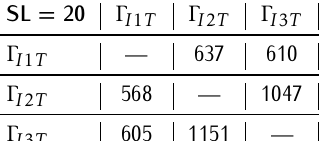
— Table 10. Number of light intensity segments and unique light signatures with various segmentation lengths for Pites (via Sibiu) trajectory